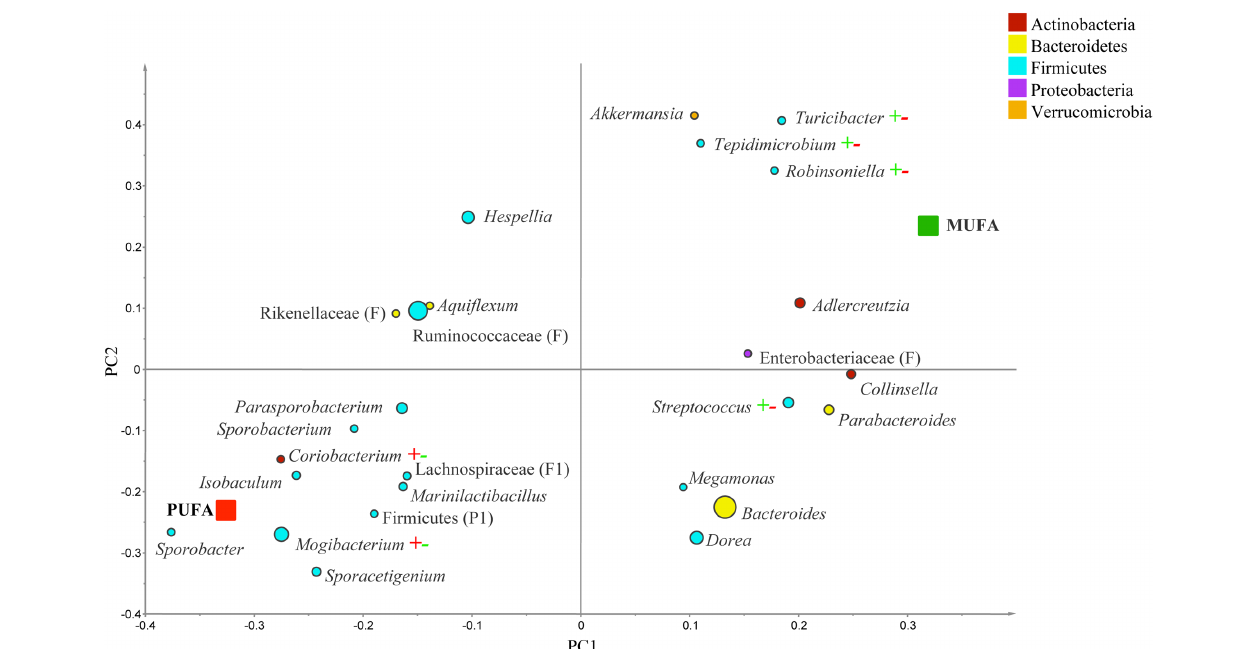
FIGURE 5 | Partial least square discriminant analysis loading plot based on the relative abundances of bacterial genera in the gut microbiota and their association with MUFA-rich or PUFA-rich diets in overweight population (BMI between 25 and 30). The presenting genera are chosen at VIP cutoff of 1.0 and colored according to their corresponding phyla. The size of circles is indicative of taxa abundance. Taxa closer to MUFA or PUFA indicate positive association with either treatment group. The R 2 ( = 0.69) and Q 2 ( = 0.26) estimates were calculated based on three components. While majority of sequences were identified at the genus level (G), some could only be affiliated to phylum (P) class (C), order (O), or family (F)